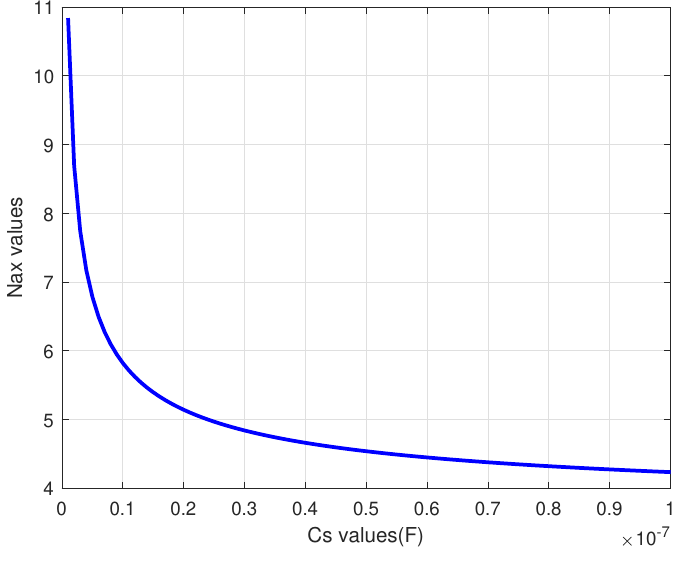
Figure 8. Values of C s and N ax .